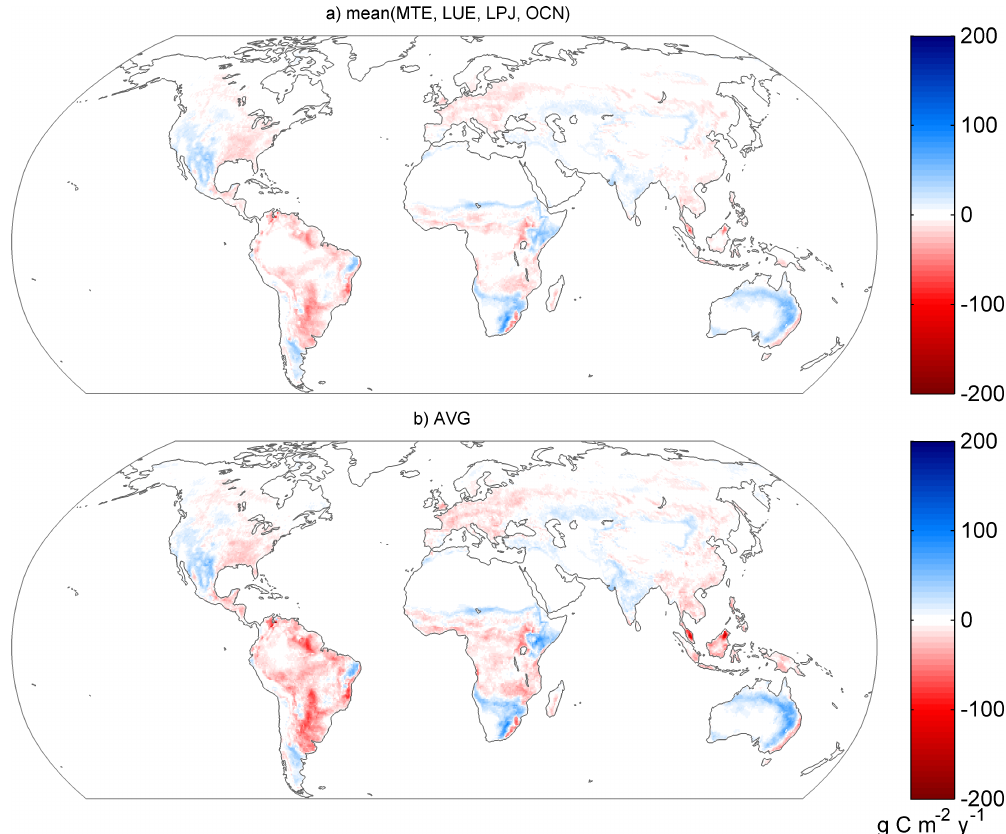
Figure 9. Pixel-wise difference between the 200 largest positive and the 200 largest negative extreme events. In the red areas negative extremes dominate. (a) Averaged difference between GPP extreme events in the four data sets MTE, MOD17+, LPJmL and OCN. (b) Difference between GPP extreme events in the averaged data set